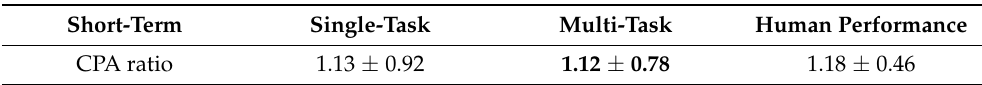
Table 7. Comparison of the CPA ratios for predicting cut-out in the practical evaluation experiment. The CPA ratio is calculated as Actual CPA / Acceptable CPA . The closer the CPA ratio is to 1, the more profitable it is for the advertiser and the media. Human performance is calculated on the day the ad operator discontinues the ad